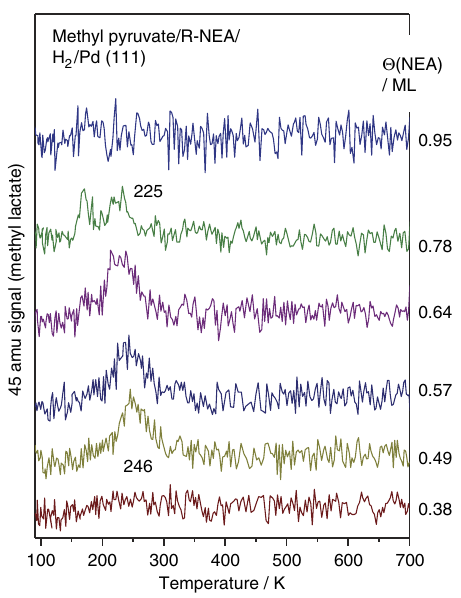
Figure 1 | TPD profiles showing the effect of NEA co-adsorption on MP hydrogenation on Pd(111). The traces show the 45 AMU (methyl lactate) TPD profiles collected following the adsorption of 3L (1L (Langmuir) ¼ 1 (cid:3) 10 (cid:4) 6 Torr (cid:2) s) of MP on a Pd(111) surface precovered with NEA and saturated with hydrogen, all dosed at a sample temperature of B 90K, as a function of NEA coverage. The NEA coverages are measured by CO site blocking and the values are displayed adjacent to the corresponding desorption